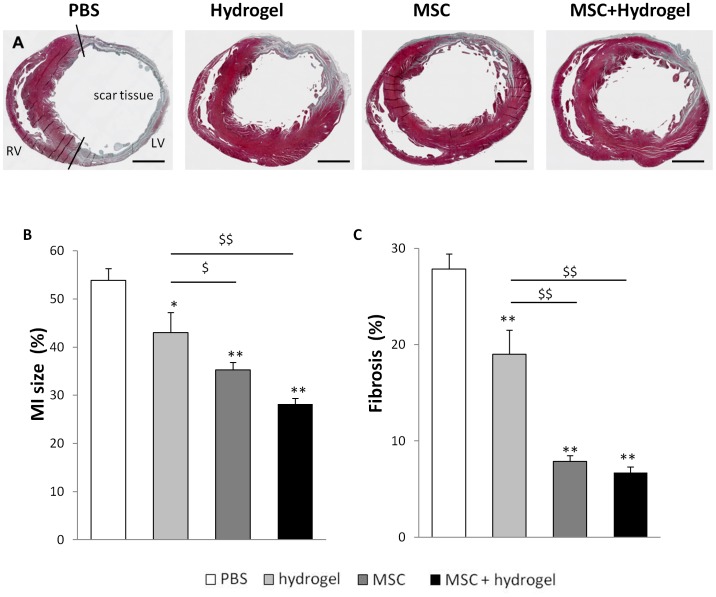
Evaluation of myocardial infarction size and left ventricular fibrosis.(A) Representative transversal histology sections of heart and Masson trichrome staining for infarct size measurement at day 56 after MI. Collagen-rich areas (scar tissue) are colored in blue and healthy myocardium in red. Scale bar = 1.5 mm. (B) Percentage of circumferential infarct size (MI size) divided by total LV tissue, and (C) percentage of fibrosis in total LV tissue. For (B) and (C): *p<0.05 and **p<0.001 vs. the PBS group, $
p<0.05 and $$
p<0.001 vs. the hydrogel group, one-way ANOVA. LV, left ventricle; RV, right ventricle. All values represent mean ± SEM.